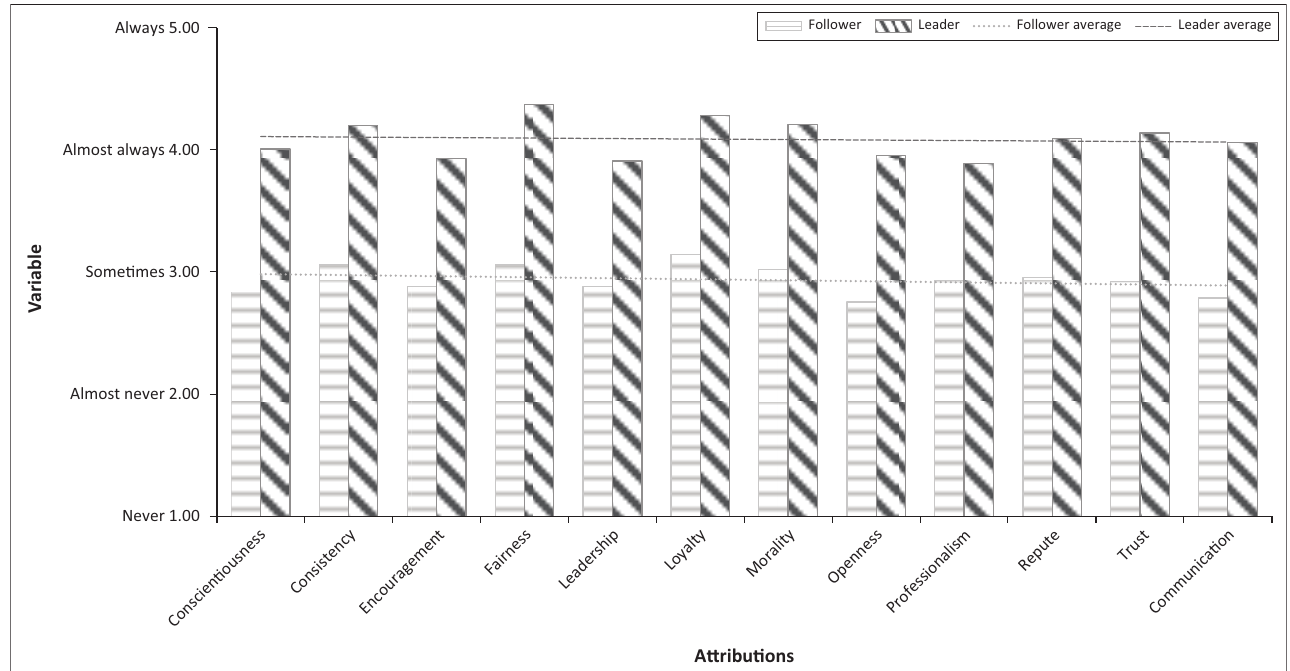
FIGURE 1: Discrepancy between leader perception of follower attributions and actual follower attributions (A x TABLE 5: One sample statistics and test (test value = 0) ( n = 102). A x _D Standard deviation